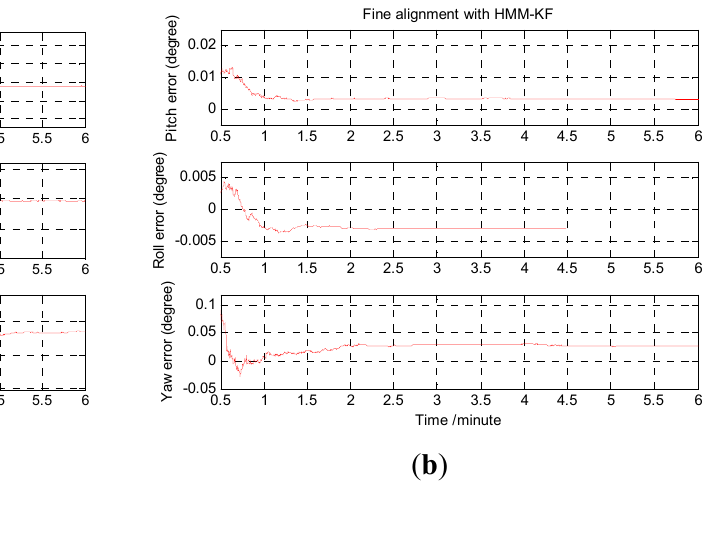
Figure 16. Estimation curves of the misalignment angles in fine alignment stage. ( a ) Fine alignment without any prefilters; ( b ) Fine alignment with HMM-KF; ( c ) Fine alignment = 3 with FIR; ( d ) Fine alignment with IIR ( N IIR